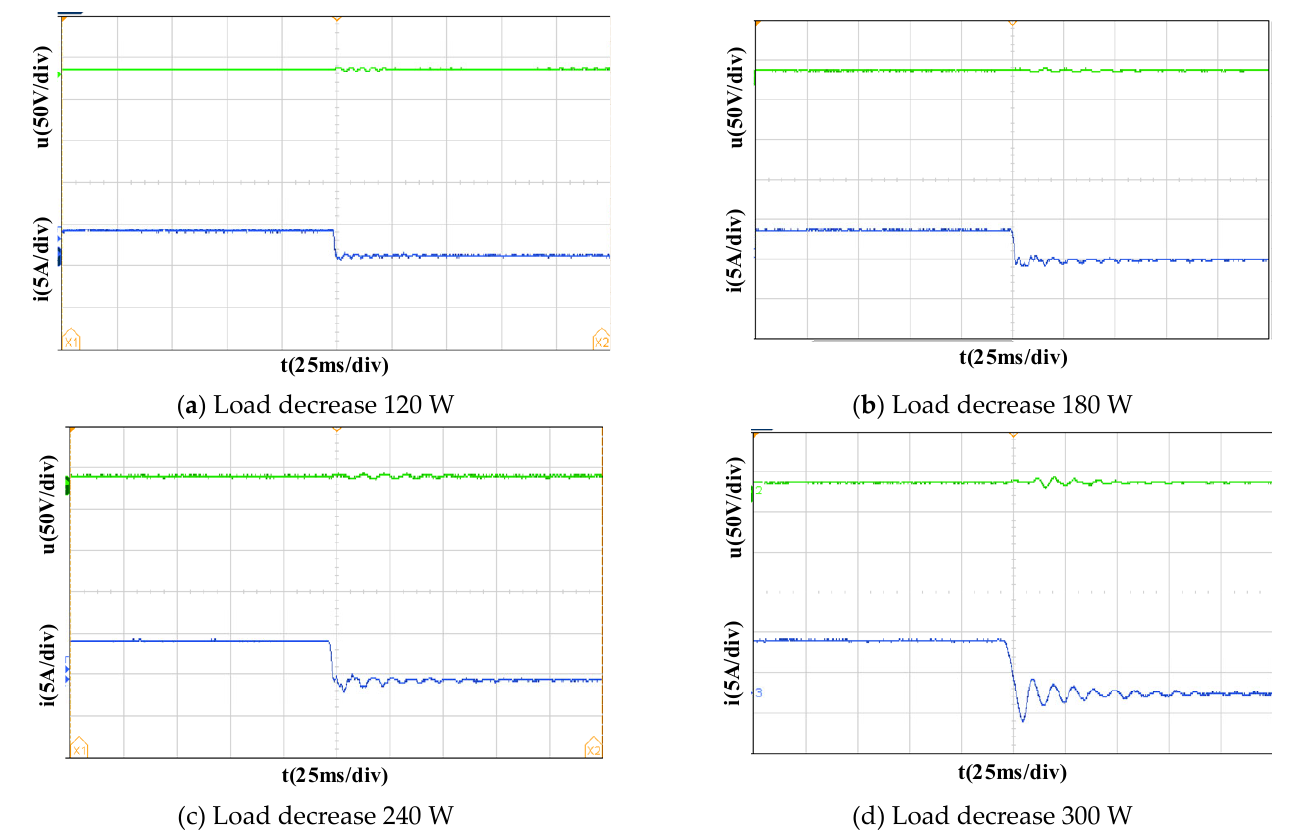
Figure 9. Experimental waveform under load suddenly decreases, ( a ) Load decrease 120 W, ( b ) Load decrease 180 W, ( c ) Load decrease 240 W, ( d ) Load decrease 300 W. In Figure 9, the green curve is the DC bus voltage response waveform; the blue curve is the battery current response waveform. In Figure 9a–d, the output current of the battery is stable at 7.5 A at the beginning, and then rapidly decreases to 5.1, 4, 2.9, 1.8 A after the load suddenly decreases. The bus voltage fluctuation range caused by the load suddenly decreasing is about 4.8, 5, 5.2, 6 V. Figure 10 is the response waveform of the DC bus voltage and battery terminal current when the load continuously dynamically fluctuates. Curve 1 is the DC bus voltage, and curve 2 is the battery current. The system is stable at the beginning, and the initial constant power load is 100 W. From point a, the constant power load fluctuates continuously and randomly in a large range of 200 W. When it reaches point b, the load fluctuation stops and the system returns to stability. The continuous fluctuation of the load causes the bus voltage to fluctuate about 3.6